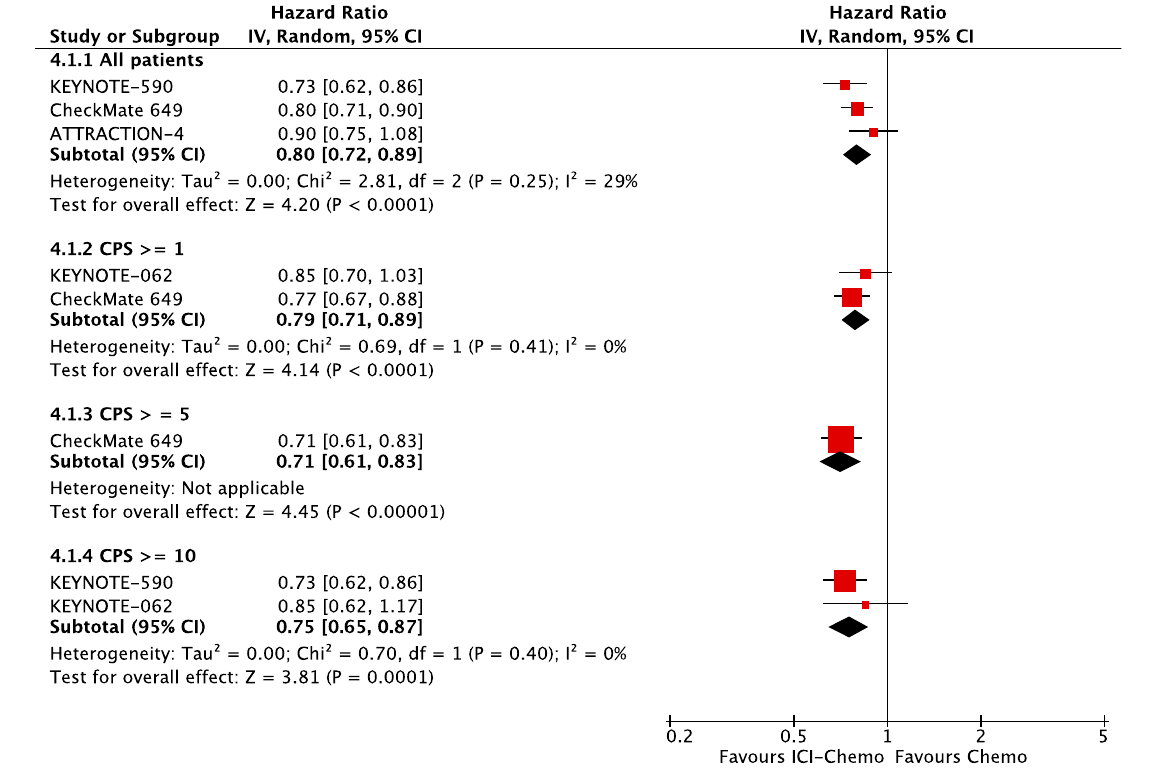
Figure 2. OS according to PD-L1 expression in the first-line setting.